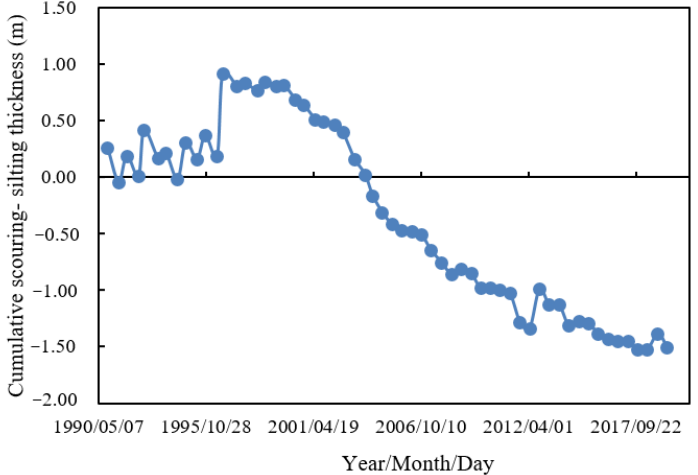
Figure 7. Cumulative year-by-year scouring-silting thickness of Huayuanzhen-Peiyu reach. (3) The relationship between the upward or downward moving distance of